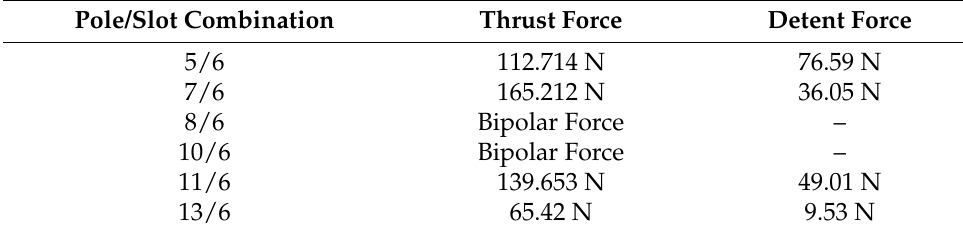
Table 2. Different stator poles